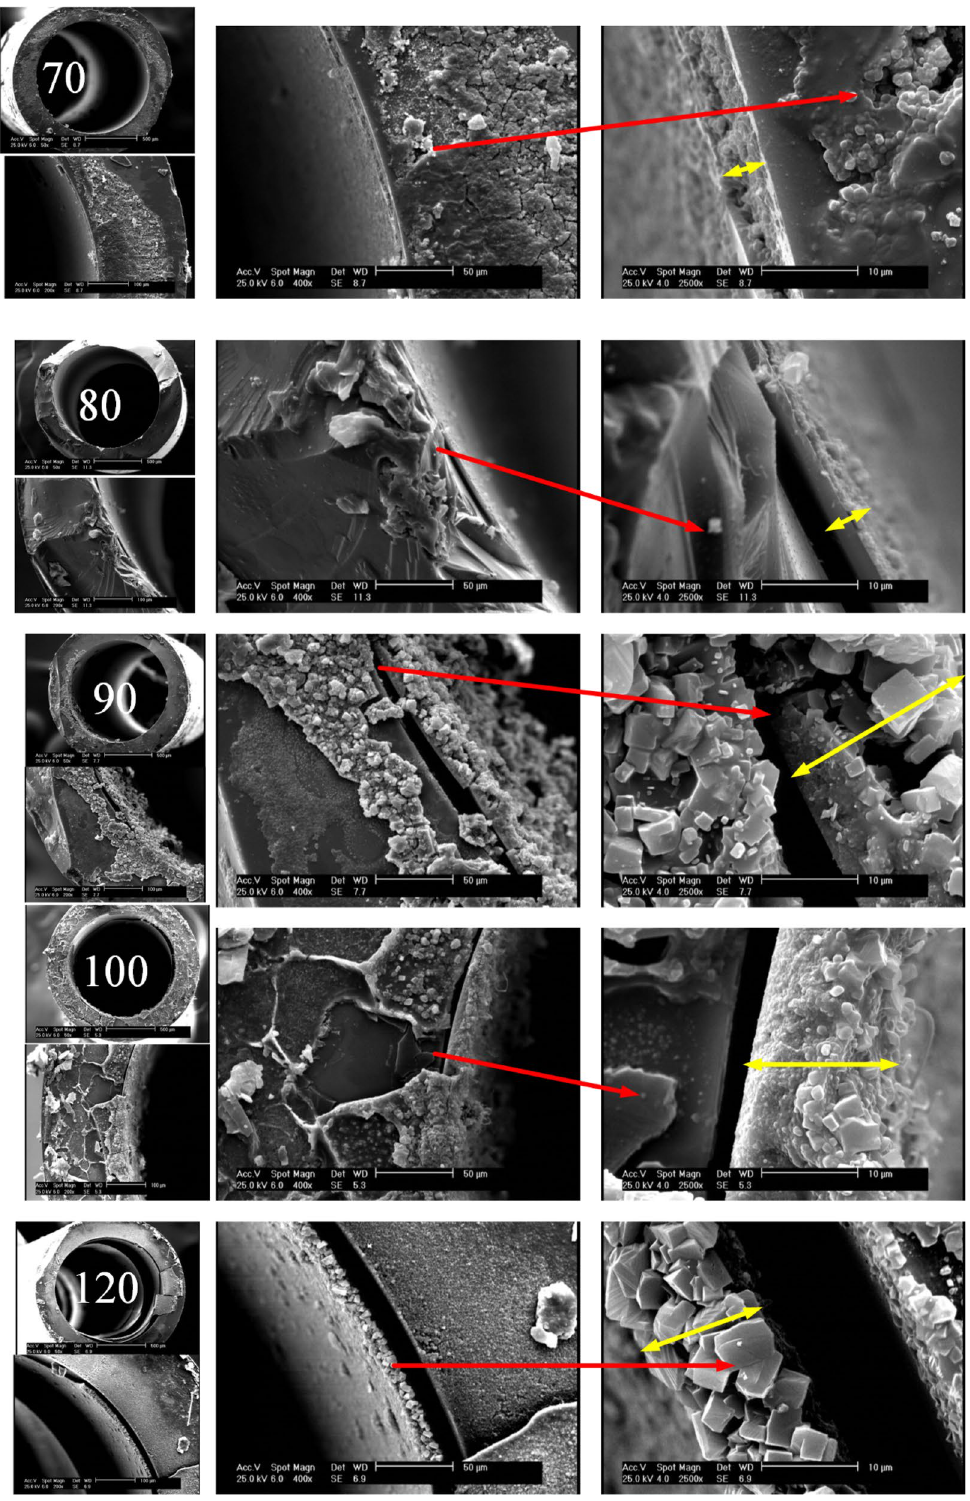
Figure 2. Cross-section SEM images of photo-catalysts grown within the inner wall of the capillaries at 70–120